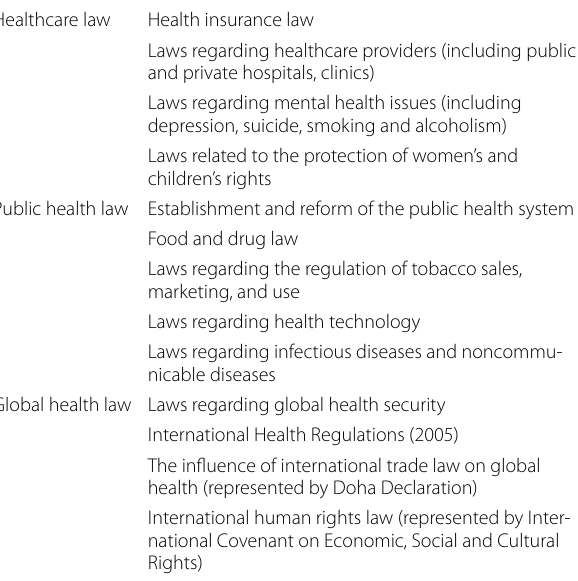
Table 1 The scope of health